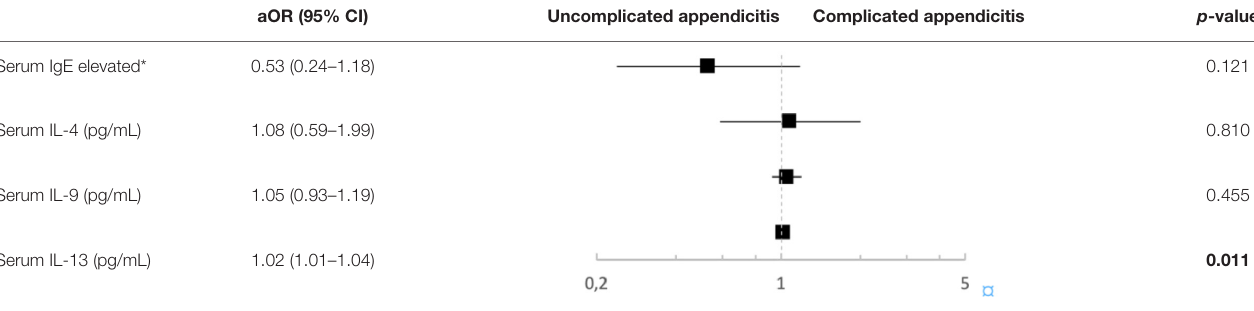
TABLE 4 | Adjusted variables for complicated appendicitis in 138 children with appendicitis. aOR (95%